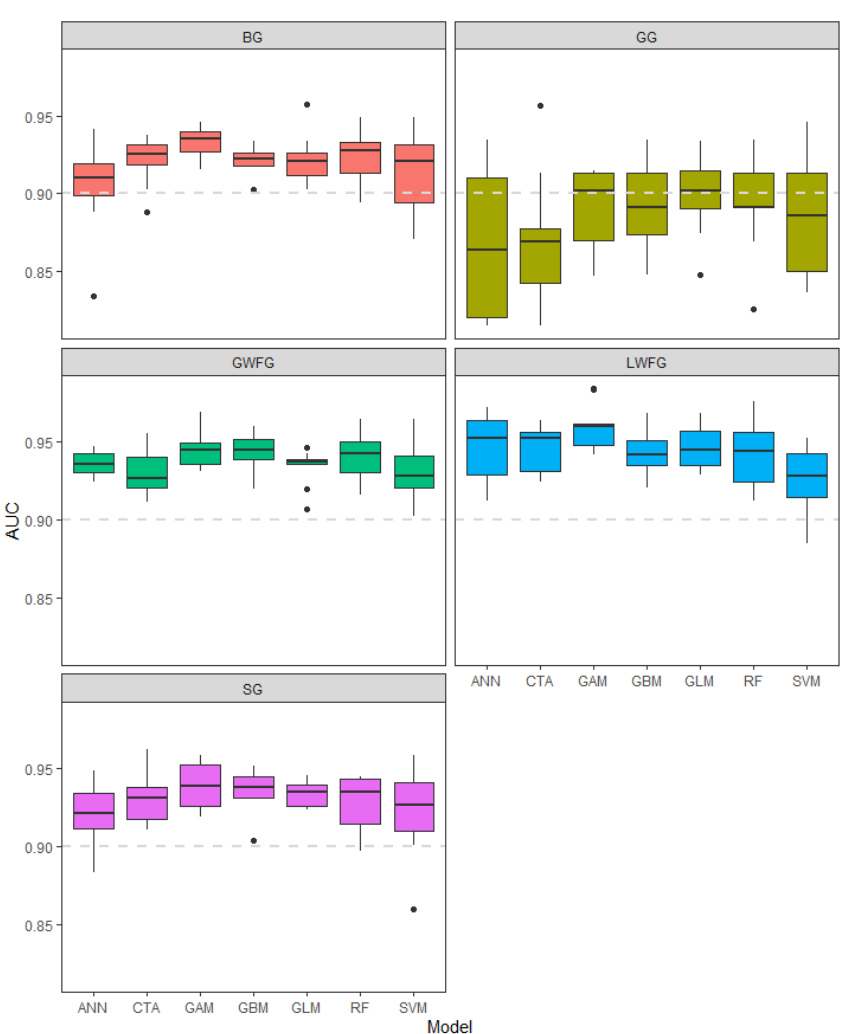
Figure 2. Box plots of interquartile range (IQR), range, and median model performance of the seven modeling algorithms used to predict the habitat suitability of five goose species. The dots are potential outliers which are greater than the 75th percentile + 1.5 IQR or less than the 25th percentile − 1.5 IQR. The medians are represented by thick black lines. Generalized linear model (GLM); random forest (RF); support vector machines (SVM); artificial neural network (ANN); generalized additive model (GAM); classification tree analysis (CTA); generalized boosting model (GBM); lesser white-fronted goose (LWFG); greater white-fronted goose (GWFG); bean goose (BG); swan goose (SG); and greylag goose